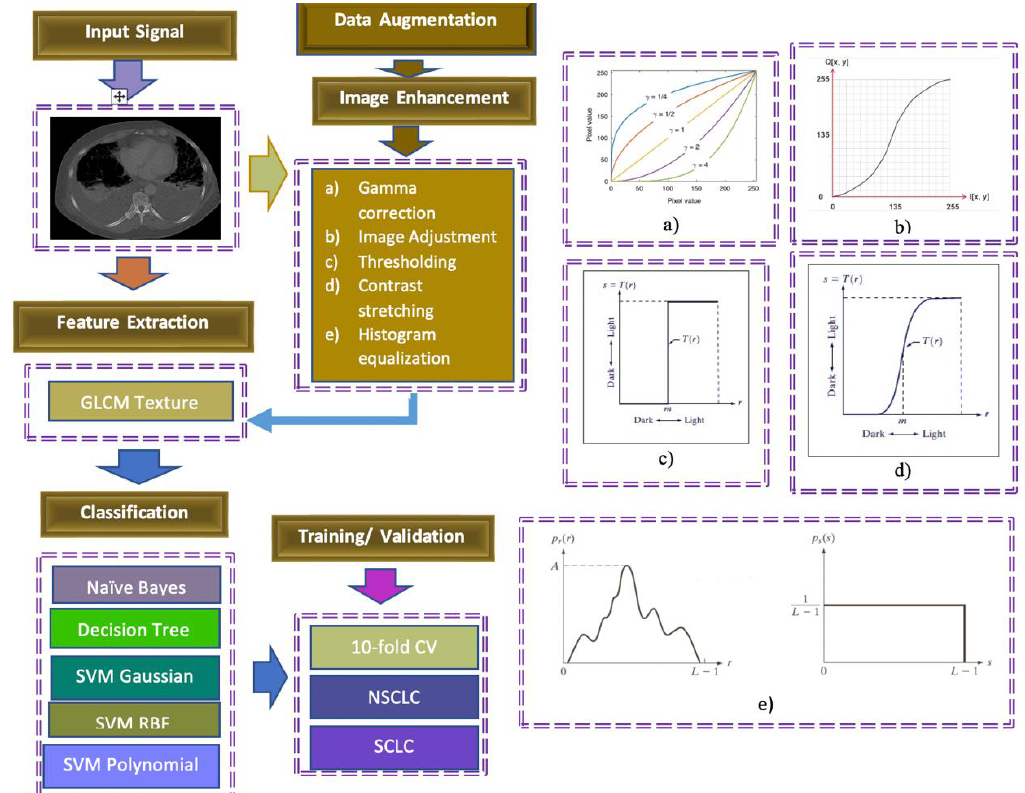
Figure 1. Schematic diagram for lung cancer detection based on image enhancement methods on GLCM texture features by utilizing machine learning techniques.